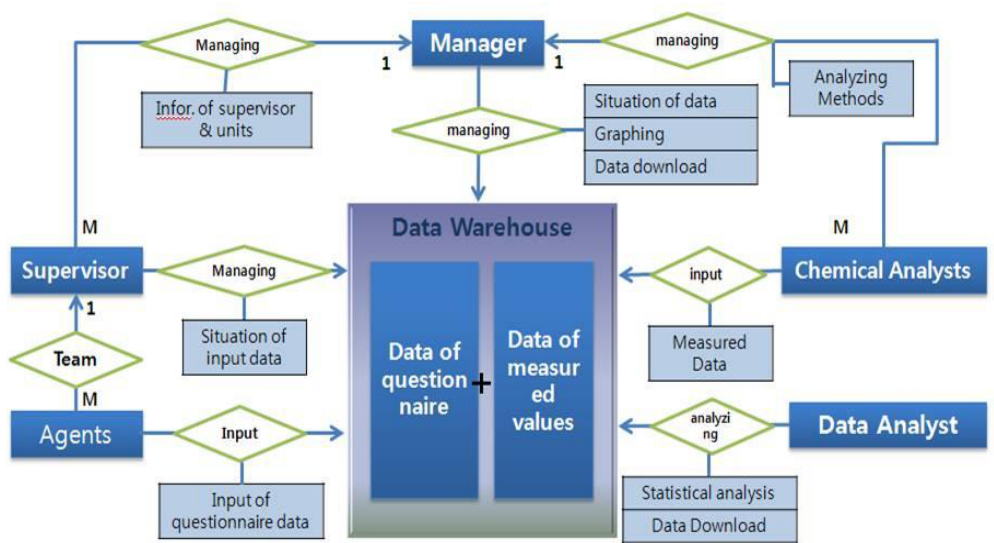
Figure 3. A web-based entity–relationship diagram (ERD) system for the management of questionnaire data and biomonitoring data in this